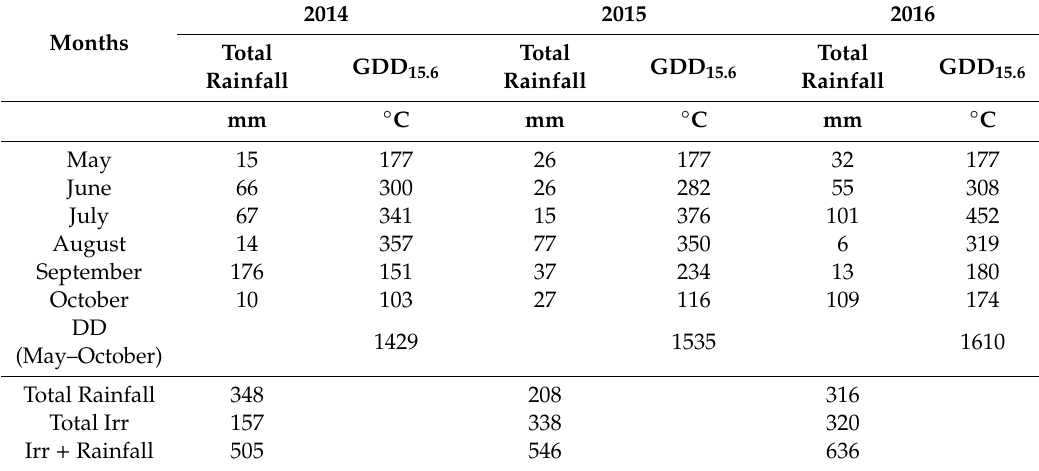
Table 5. Total rainfall, growing degree days and the amount of irrigation water used in 2014, 2015 and 2016 growing